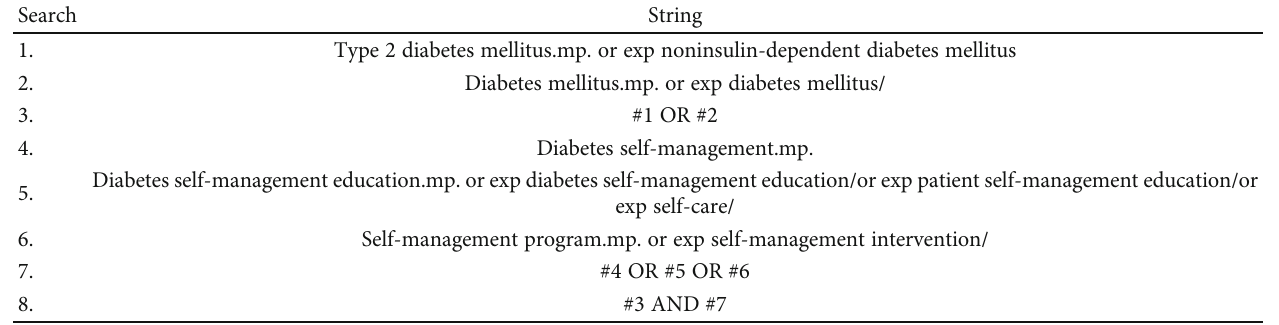
Table 1: Detailed search strategy for the scoping review of Diabetes SME interventions.